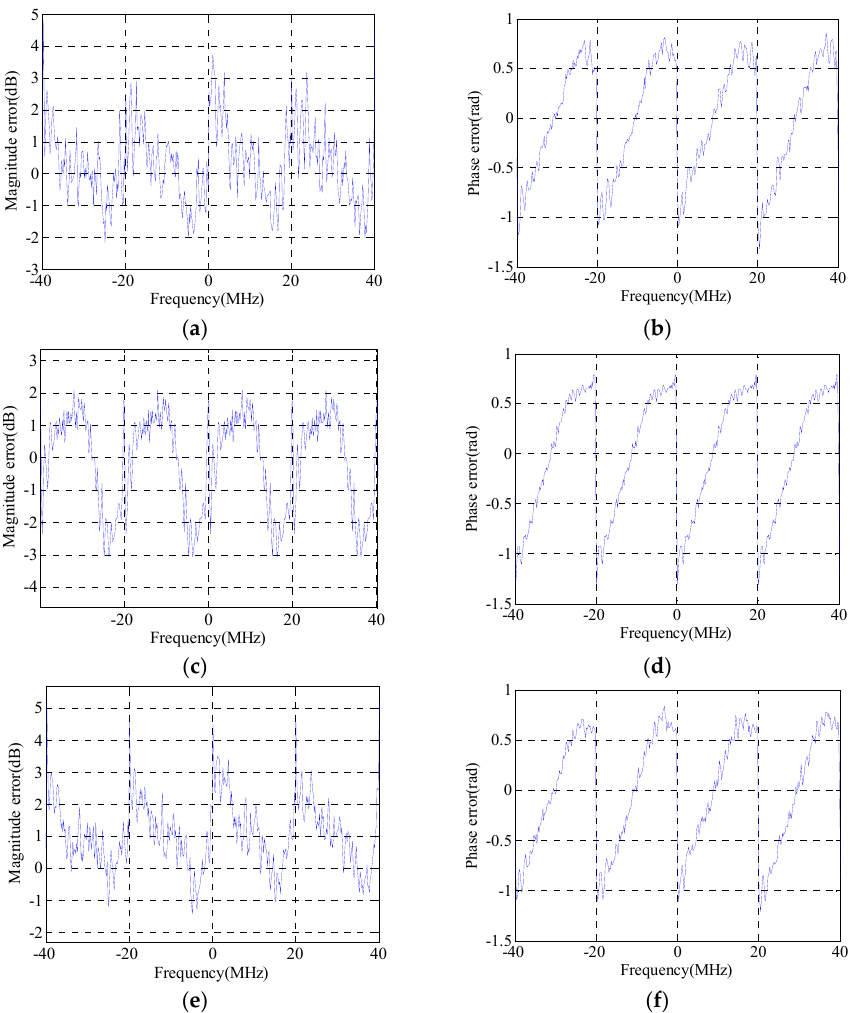
Figure 3. MEPE in SWW: ( a ) added magnitude error; ( b ) added phase error; ( c ) estimated magnitude error by GLPP; ( d ) estimated phase error by GLPP; ( e ) estimated magnitude error by the proposed method; and ( f ) estimated phase error by the proposed method. Table 1. Magnitudes of grating lobes before and after GLS.